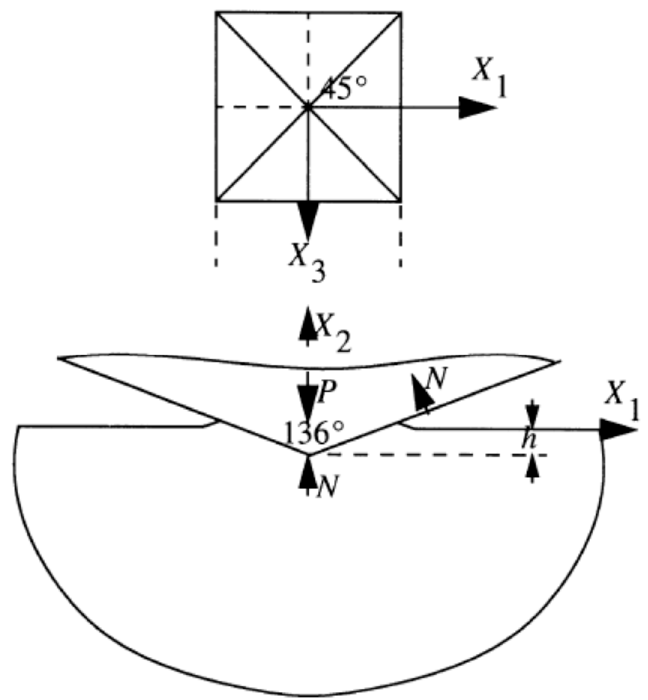
Figure 1. Schematic of the geometry of the Vickers indentation test.